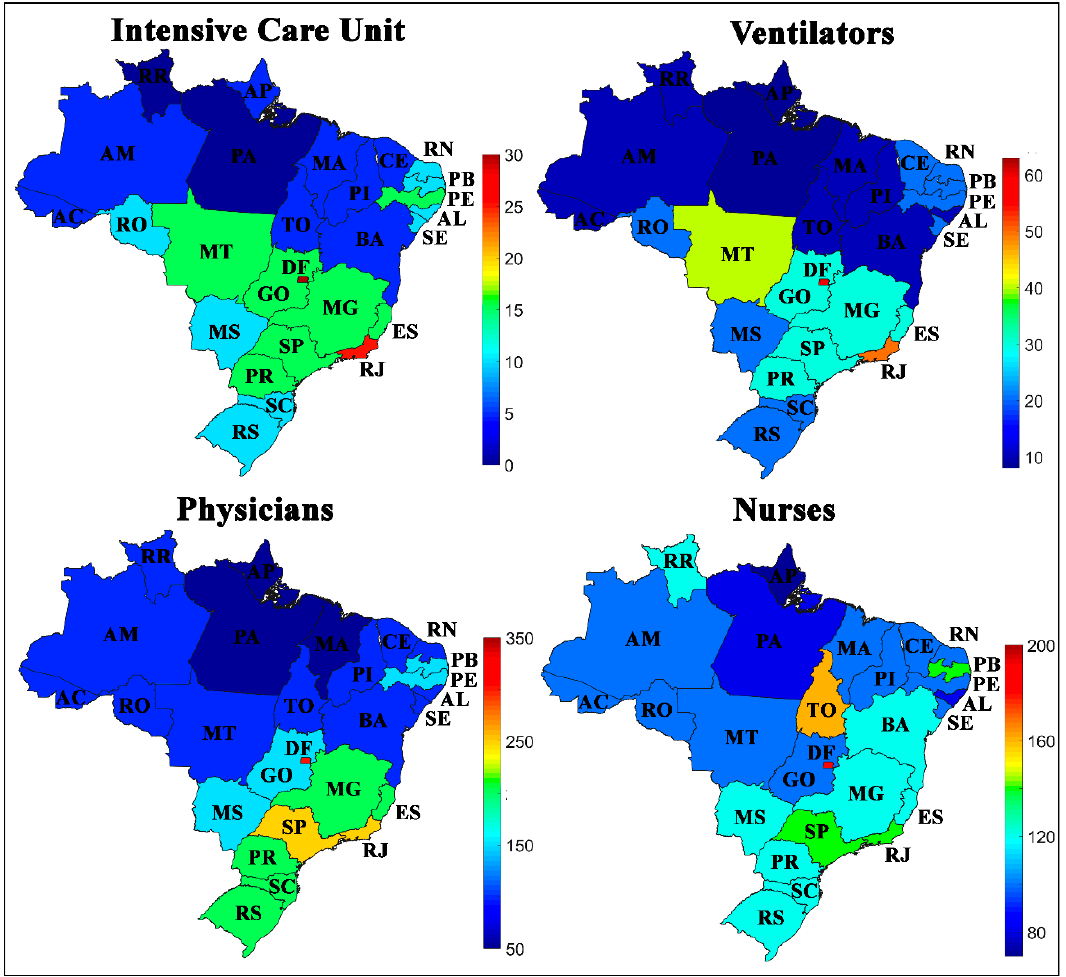
Figure 3. Geographical distribution of Intensive Care Unit (ICU) bed, ventilators, physicians and nurses in Brazilian states per 100,000 inhabitants.